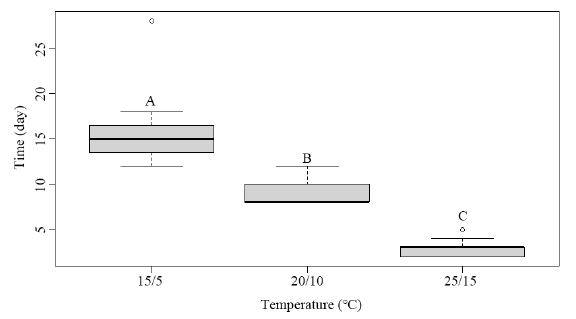
Figure 3. Mean time (days) needed for root emergence under different temperature conditions. Different uppercase letters indicate significant differences between the incubation temperature regimes (Tukey’s HSD test, p = 0.05 ).